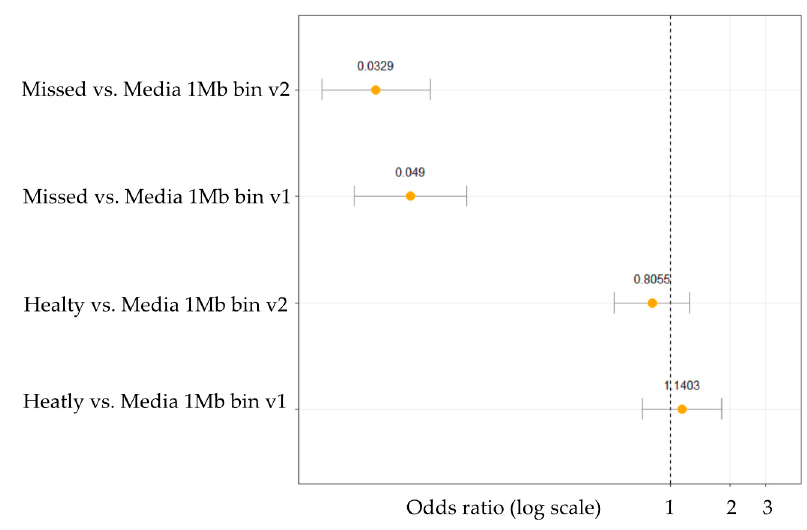
Figure 3. Odds ratio analysis for CNV in culture media droplets of aborted embryos (Missed) compared to control media and culture media droplets of healthy neonates (Healthy) compared to control media. Odds ratios are in log transformed scale for better visualization.